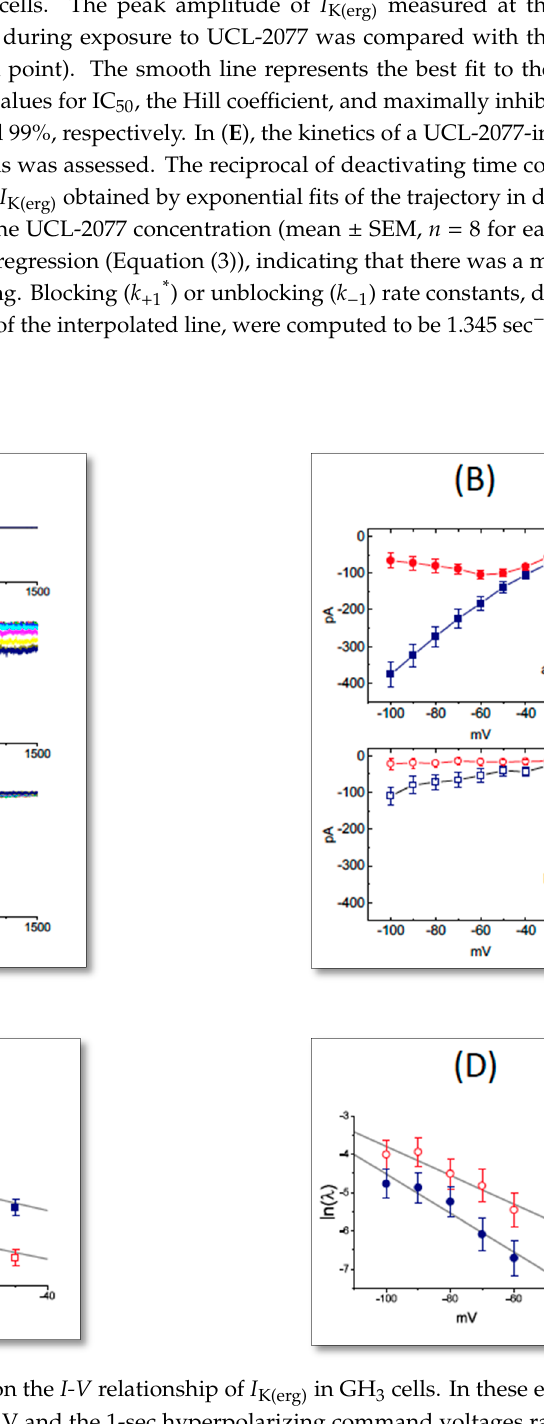
(mean ± SEM, n = 8 for each point). The smooth line represents the best fit to the modified Hill